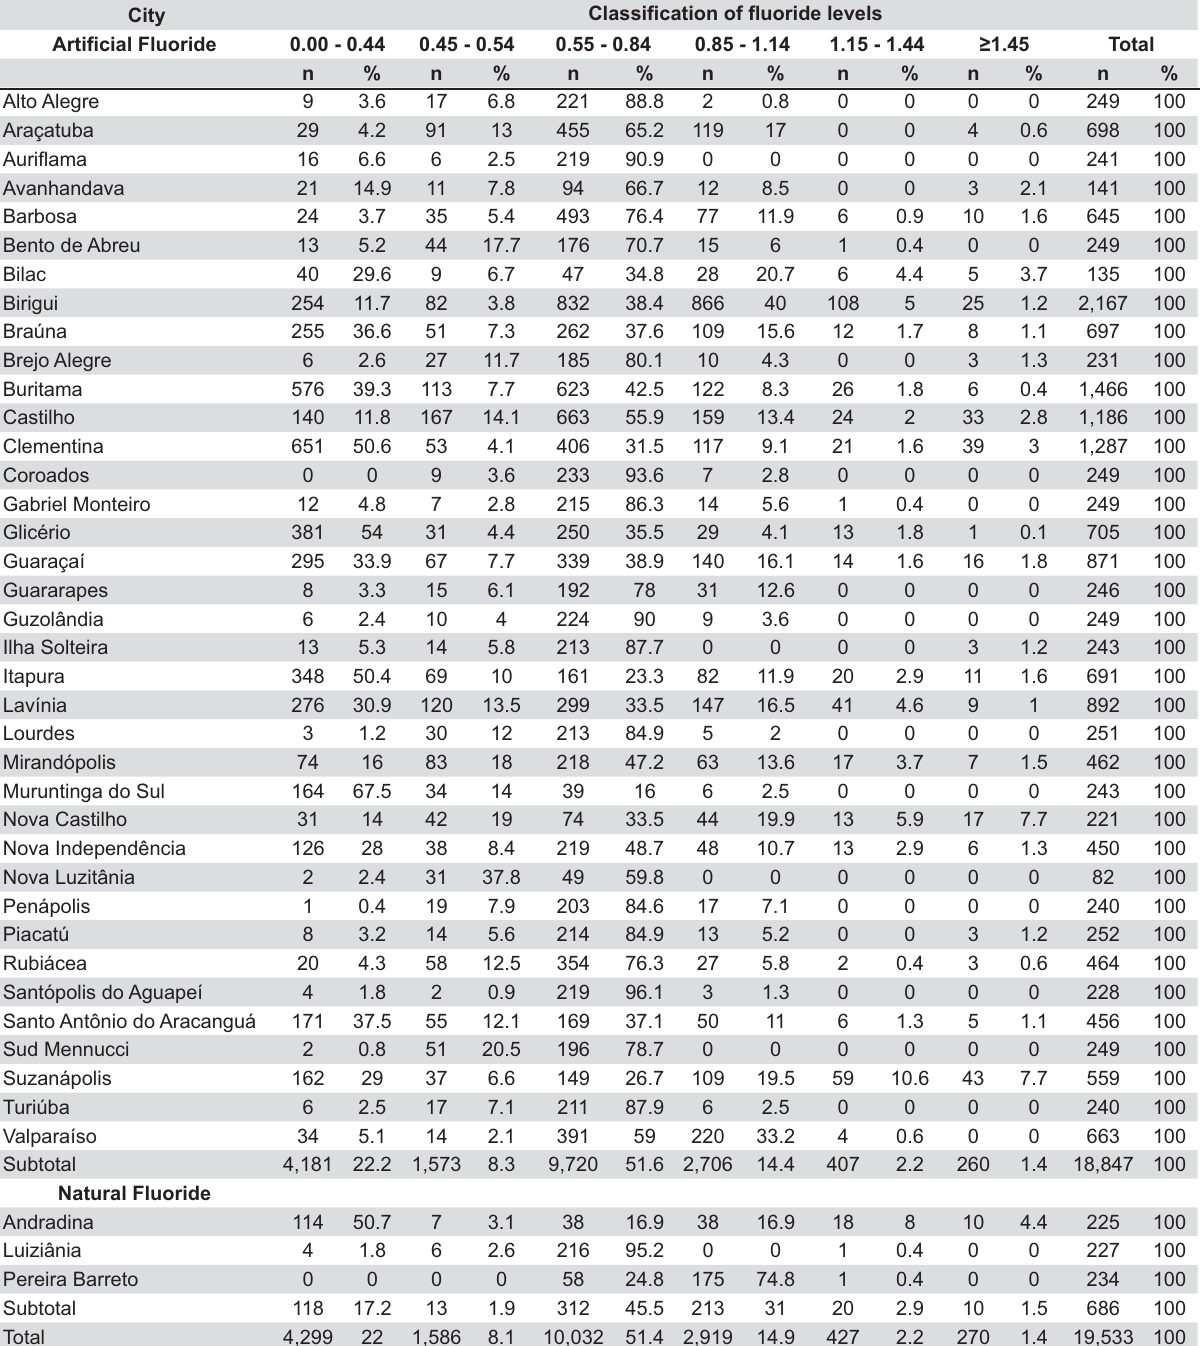
Table 1- (cid:9)(cid:10)(cid:5)(cid:11)(cid:12)(cid:4)(cid:5)(cid:13)(cid:3)(cid:12)(cid:5)(cid:14)(cid:15)(cid:9)(cid:14)(cid:16)(cid:9)(cid:11)(cid:7)(cid:8)(cid:17)(cid:18)(cid:19)(cid:11)(cid:9)(cid:16)(cid:4)(cid:14)(cid:8)(cid:9)(cid:17)(cid:3)(cid:13)(cid:18)(cid:5)(cid:20)(cid:9)(cid:21)(cid:7)(cid:12)(cid:19)(cid:4)(cid:9)(cid:11)(cid:3)(cid:17)(cid:17)(cid:18)(cid:5)(cid:19)(cid:11)(cid:9)(cid:16)(cid:4)(cid:14)(cid:8)(cid:9)(cid:22)(cid:23)(cid:9)(cid:24)(cid:4)(cid:7)(cid:25)(cid:5)(cid:18)(cid:5)(cid:7)(cid:15)(cid:9)(cid:20)(cid:5)(cid:12)(cid:5)(cid:19)(cid:11)(cid:26)(cid:9)(cid:7)(cid:20)(cid:20)(cid:14)(cid:4)(cid:27)(cid:5)(cid:15)(cid:28)(cid:9)(cid:12)(cid:14)(cid:9)(cid:6)(cid:3)(cid:14)(cid:4)(cid:5)(cid:27)(cid:19)(cid:9)(cid:20)(cid:14)(cid:15)(cid:20)(cid:19)(cid:15)(cid:12)(cid:4)(cid:7)(cid:12)(cid:5)(cid:14)(cid:15)(cid:9) (mgF/L), from November 2004 to October 2011